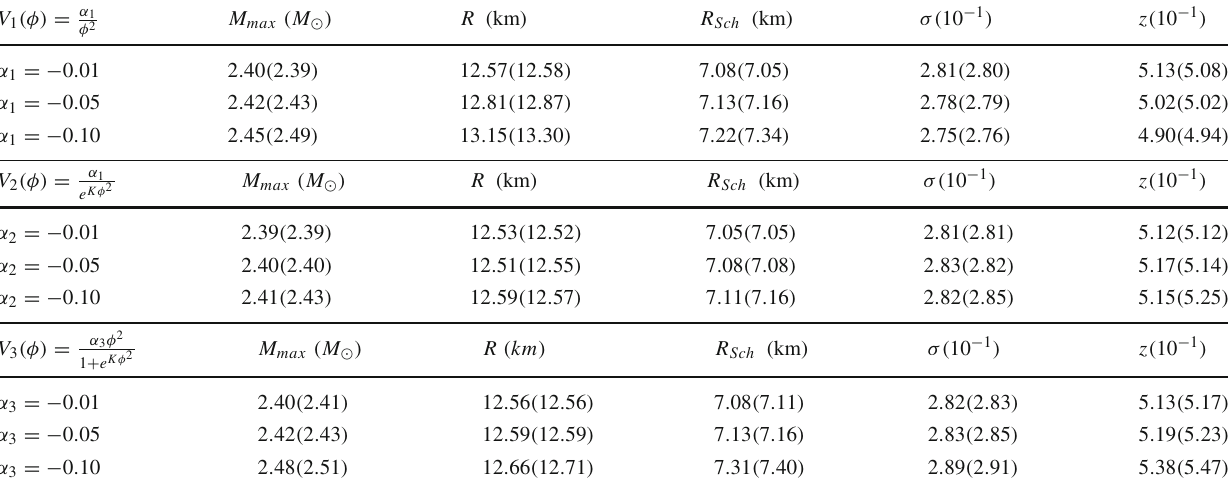
Table 8 Structure properties of neutron star in mimetic gravity for FSU2H EoS with φ( 0 ) = 1 ( φ( 0 ) = 0 . 8) and K = 0 .